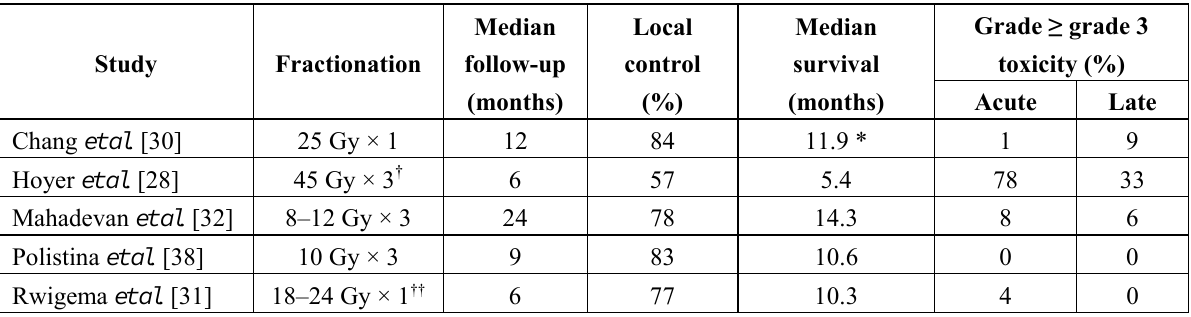
Table 1. SBRT for locally advanced pancreatic